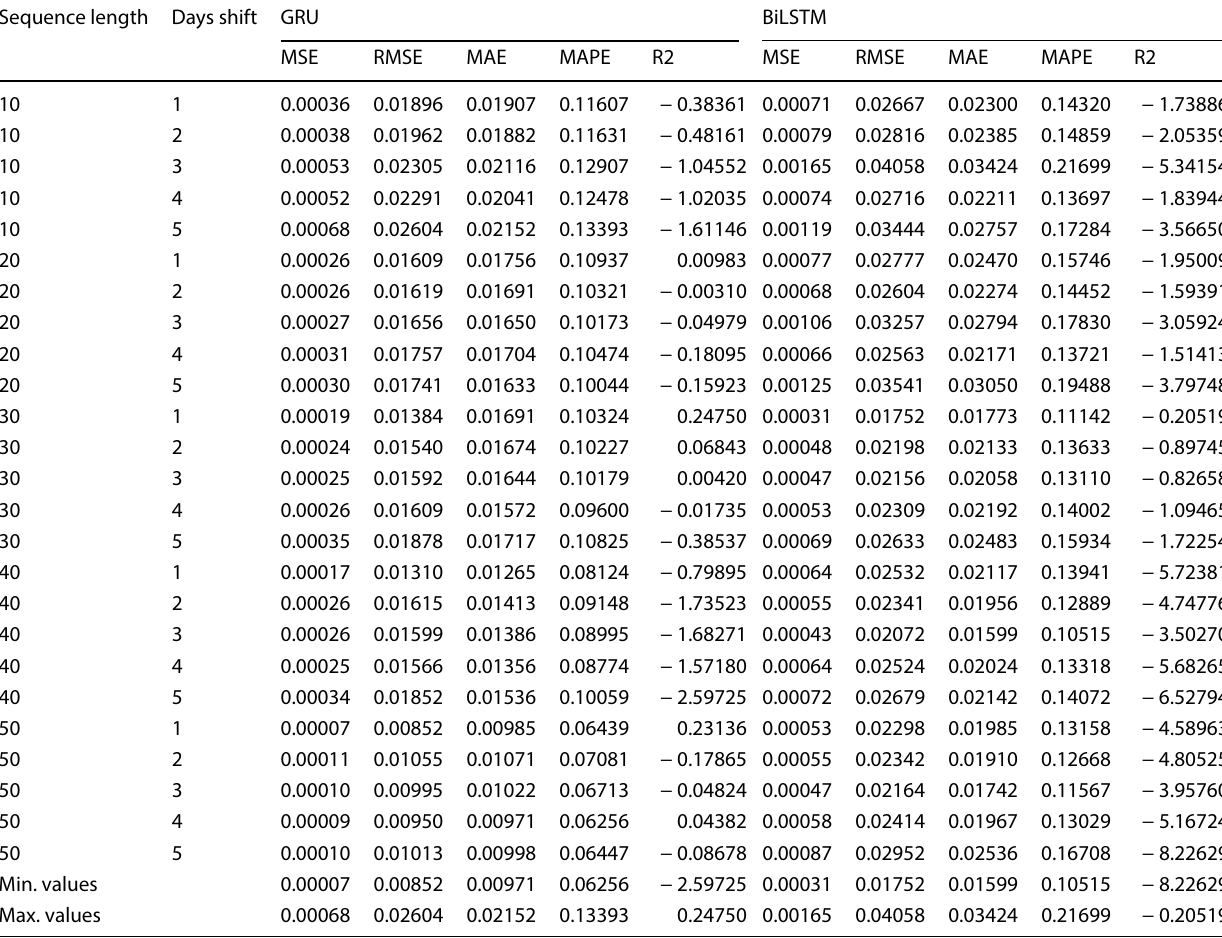
Table 7 The reported performance metrics for the “Cardano USD (ADA-USD)” dataset using the two models (i.e., GRU and